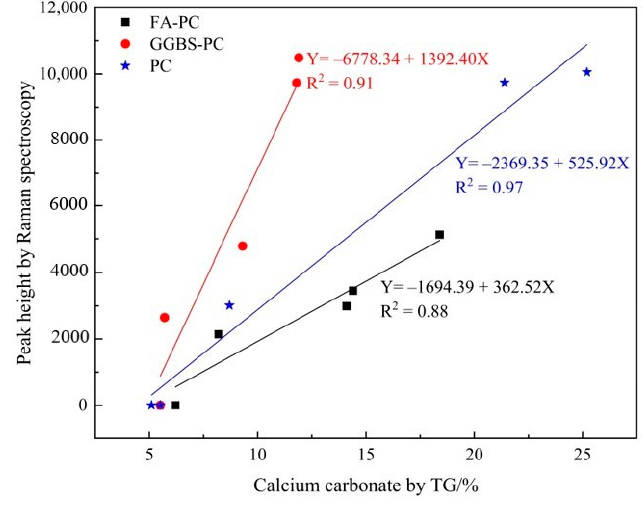
Figure 11. Correlation between the calcium carbonate in the carbonated FA/PC, GGBS/PC and PC paste samples identified by Raman spectroscopy and TG